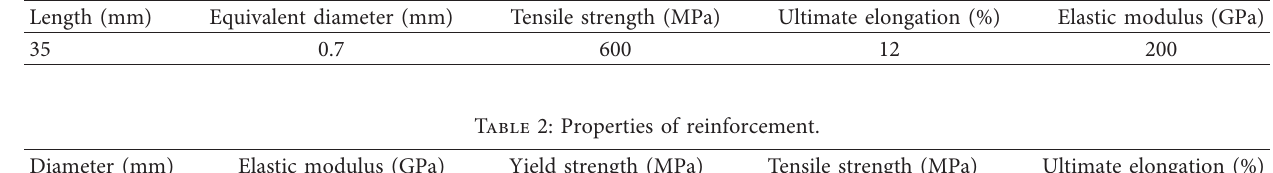
Table 1: Properties of steel fiber.